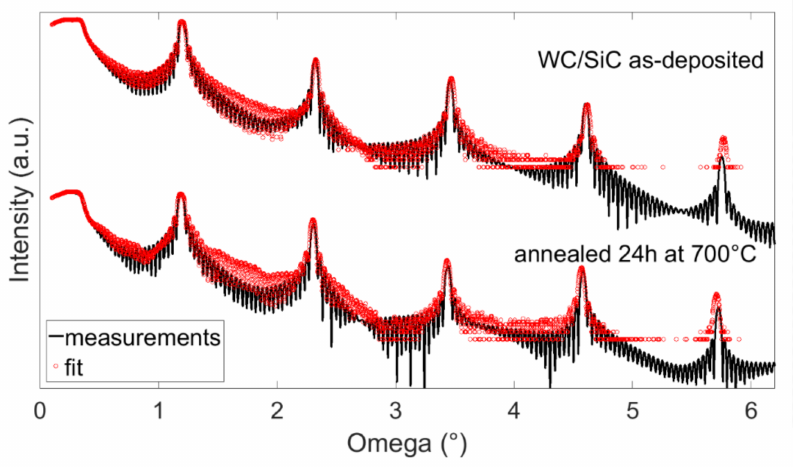
Figure 8. SAXRD experimental data and fits of the same WC/SiC multilayer before and after anneal at 700 ◦ C for 24